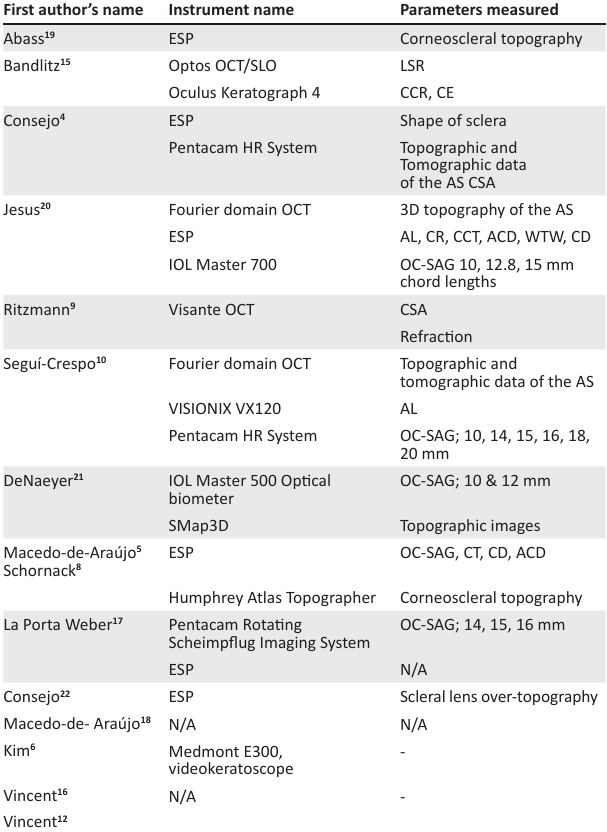
TABLE 3: Instrument name and parameters as